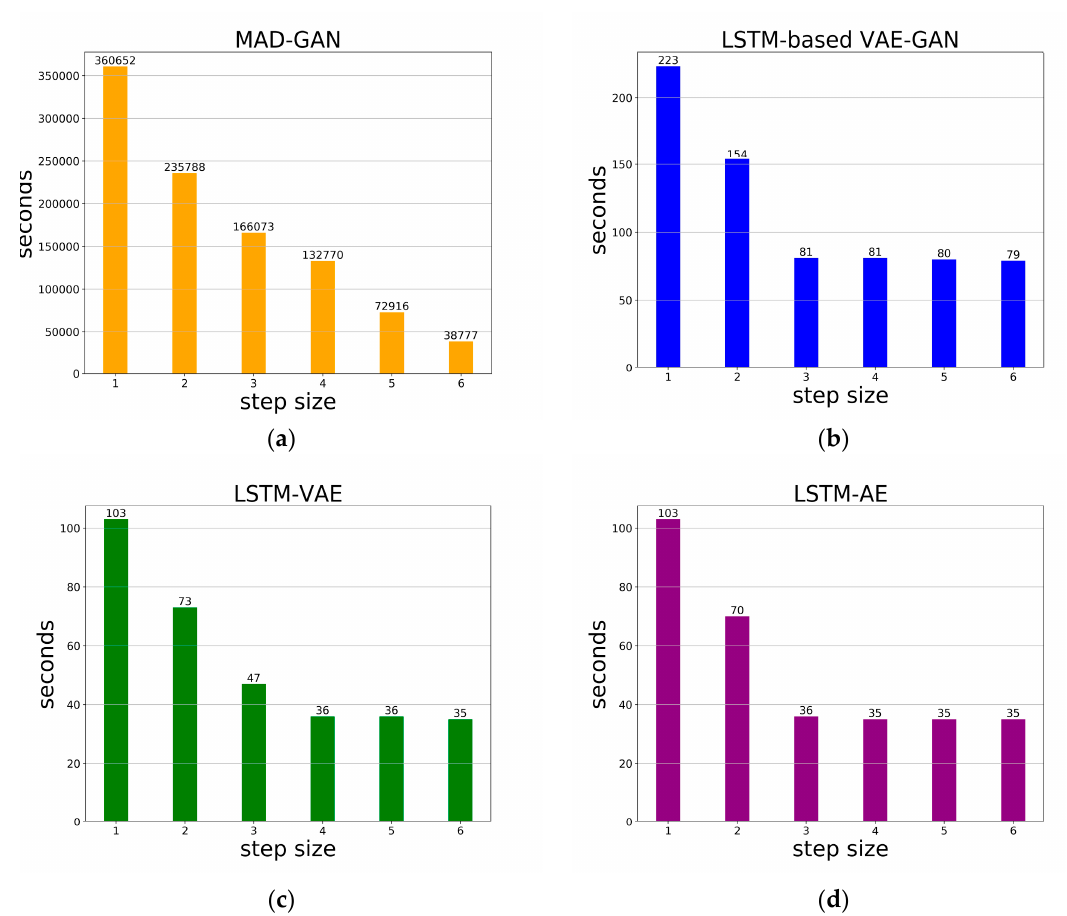
Figure 3. With di ff erent step sizes, the time spent by four methods at the anomaly detection stage in Yahoo dataset. ( a ) MAD-GAN, ( b ) LSTM-based VAE-GAN, ( c ) LSTM-VAE, ( d )